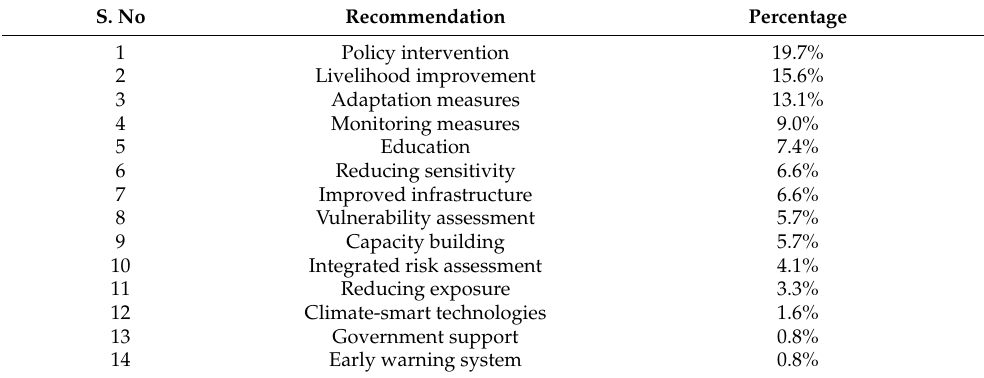
Table 5. Recommendations from the papers included in this systematic